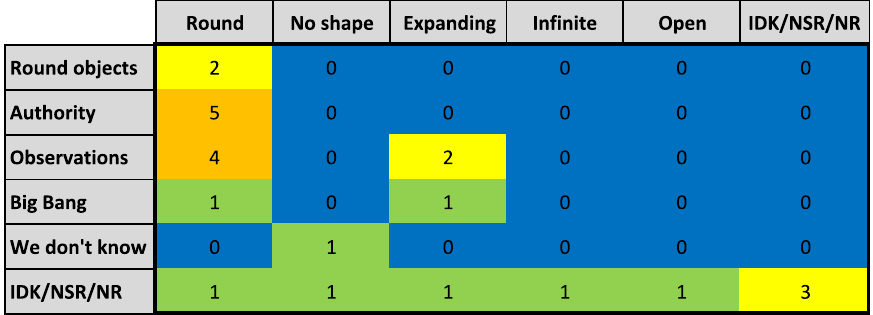
FIG. 5. Heat map highlighting relationships between ASTRO 101 students ’ ideas on the shape or geometry with their responses to How do we know ? ( N ¼ 16 ) Each cell specifies the number of responses coded with a particular combination of shape